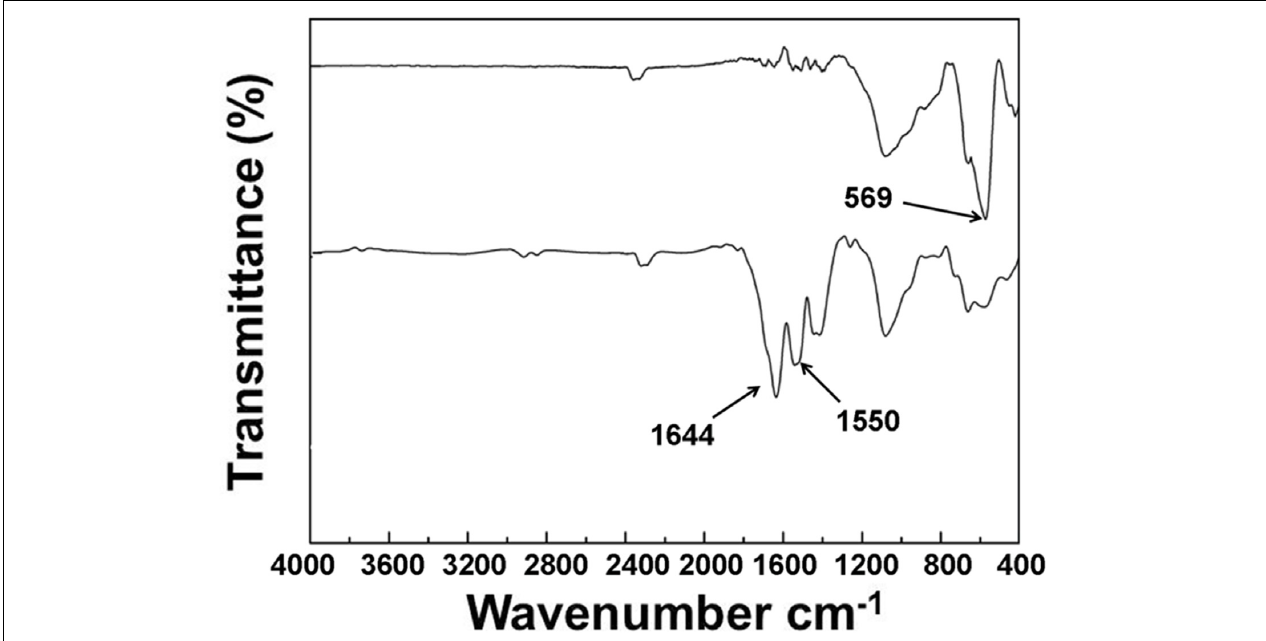
FIGURE 2 | FTIR spectra of SPION and